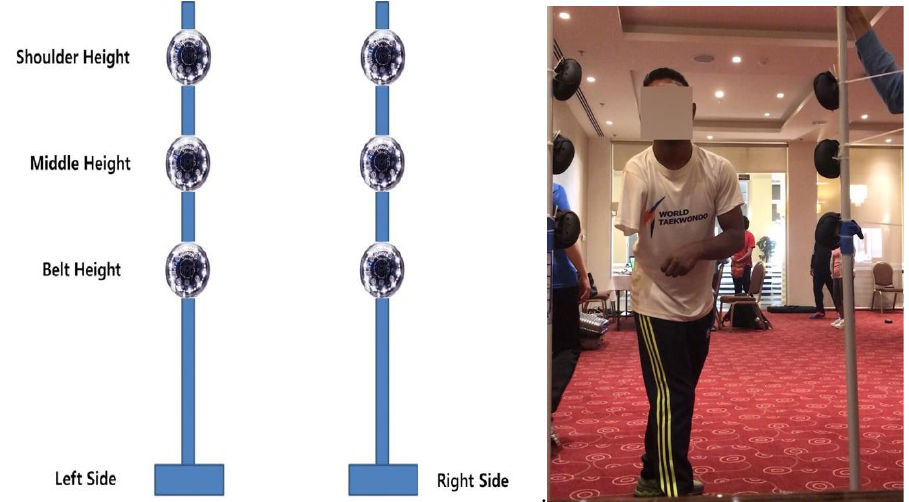
Figure 2. Front view of ROXs Pro sensors set up individually for each athlete’s height; left (schematic), right (data collection).